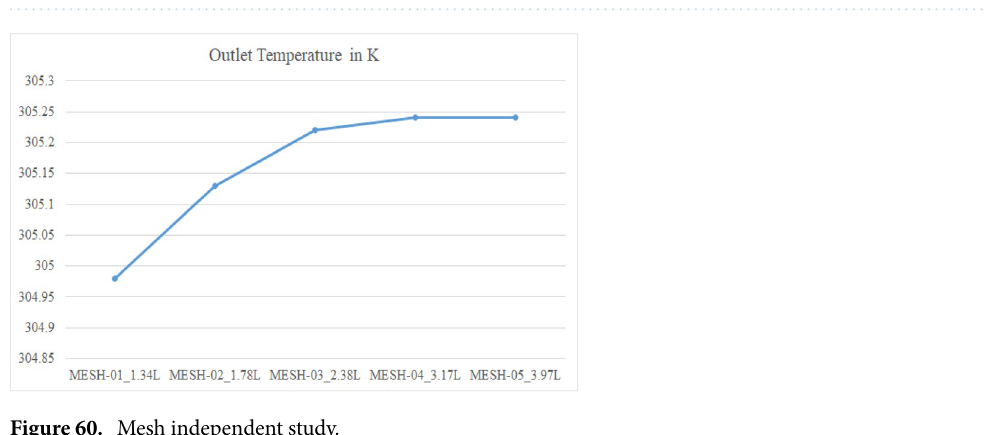
Figure 60. Mesh independent study.